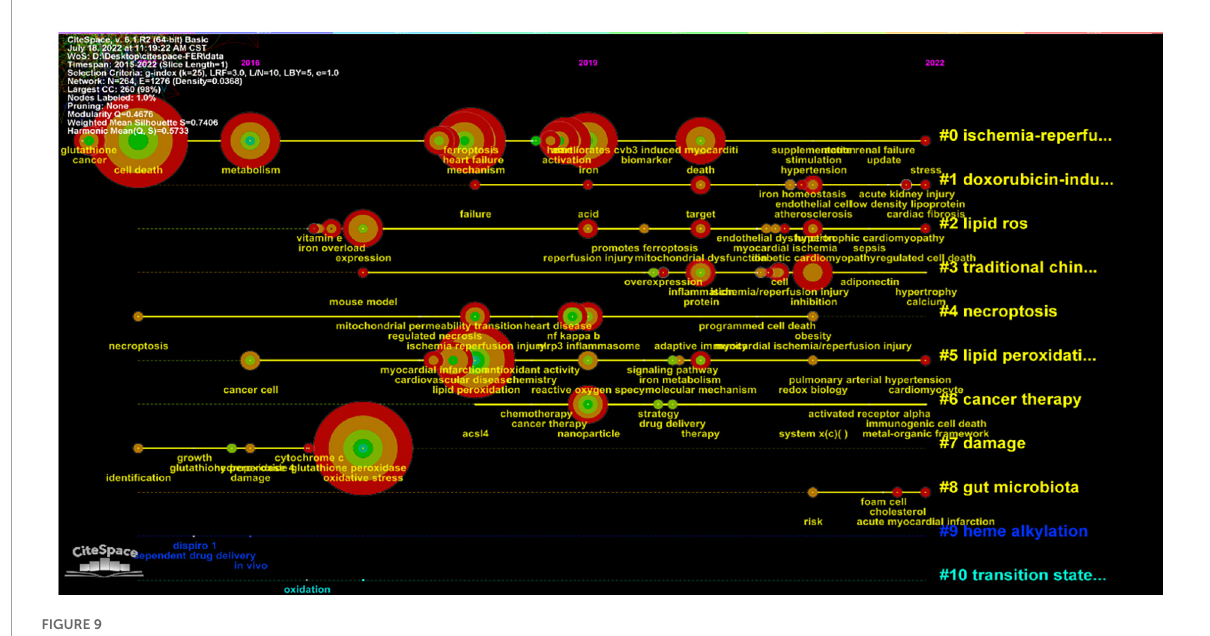
FIGURE9 Timeline visualization map of the